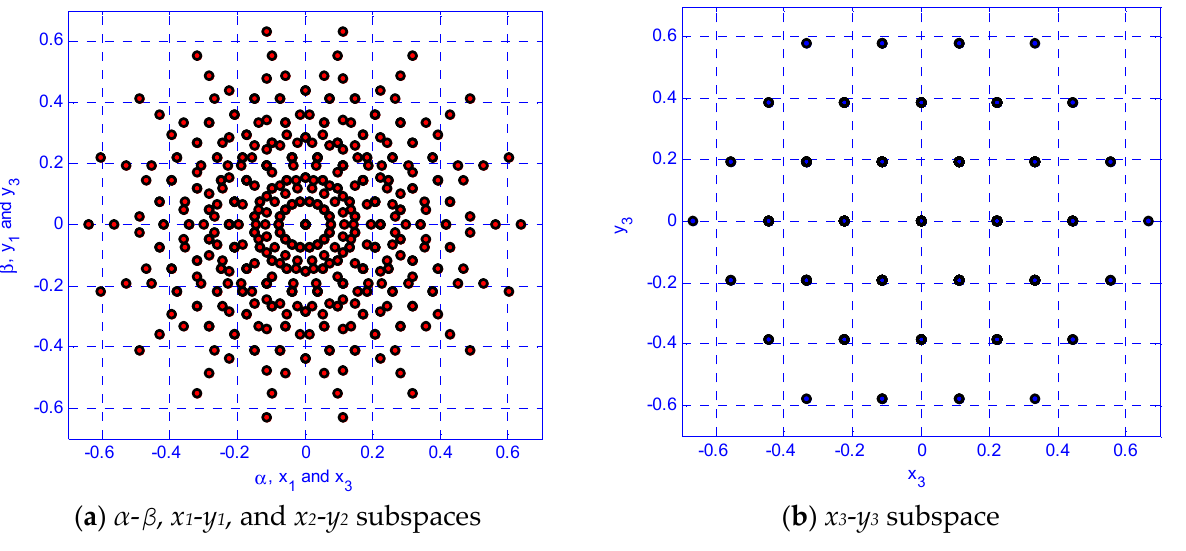
Figure 2. Output-voltage space vector planes corresponding to the switching combinations of the nine-phase VSI. Table 1. Switching Combination Groups for nine-phase VSI.